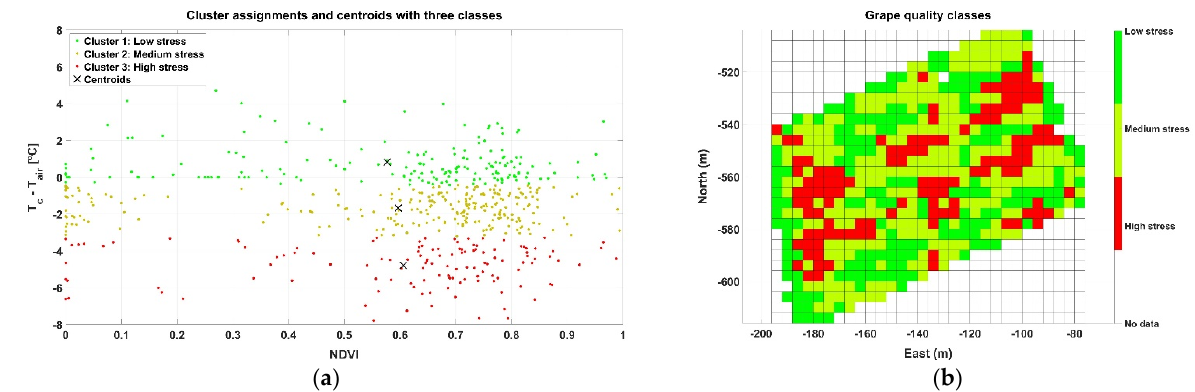
Figure 13. Clustering results and grid for Map B: ( a ) three classes (k = 3) clustering results; and ( b ) zoning.